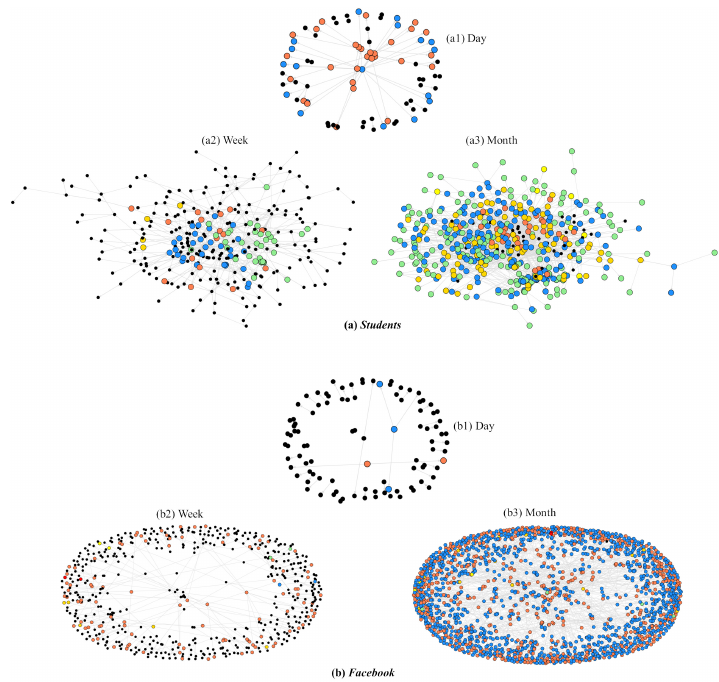
Figure 10. Community structure of Students and Facebook in one day, one week, and one month, respectively. Nodes in black denote that they do not belong to any community obviously yet.